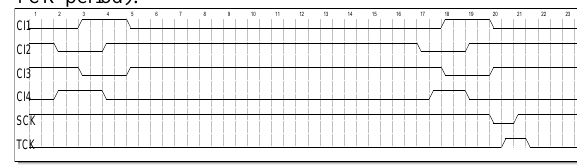
Figure 8. Continuous transfer clock sequence diagram TDICCD continuous transfer clocking technology maximizes the isolation of vertical transfer clocking and horizontal transfer clocking by controlling the clocking design of electrode SCK and TCK between vertical and horizontal transfer of sensors, so that the clocking of horizontal transfer is not related to the timing of vertical transfer. Then CI clocking can be designed as a transmission time of the CRX timing. Thus, the TDICCD charge